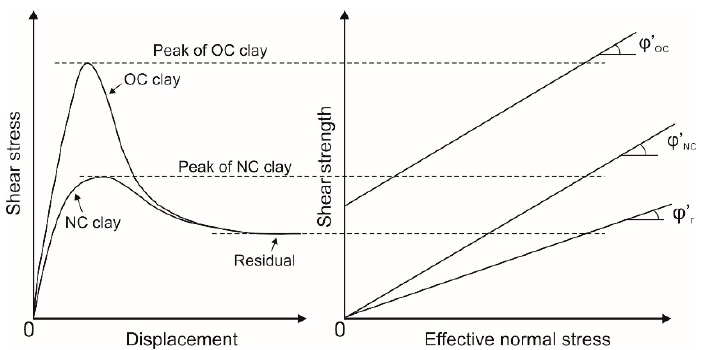
Figure 1. Stress-displacement curves (left-hand side) and failure lines of over-consolidated (OC) and normal consolidated (NC) clay (right-hand side), (based on [9]); description in the